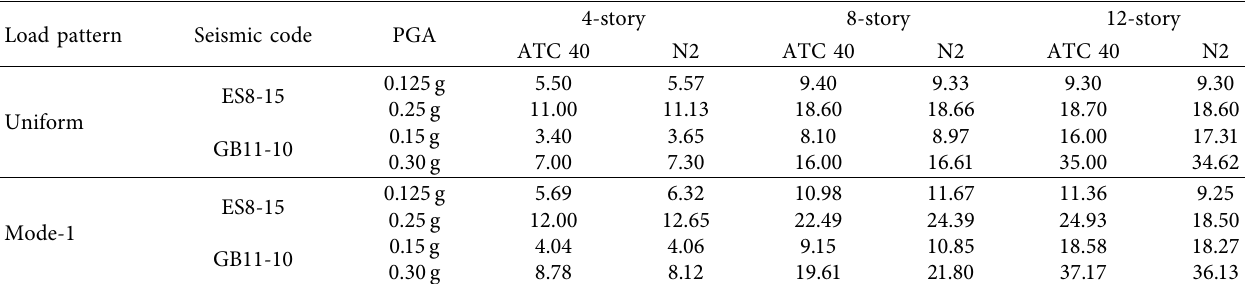
Figure 14: ADRS Response spectra and capacity curve for ES8-15 and GB11-10. Table 5: Target displacement (in cm) capacity spectrum method ATC-40 and N2